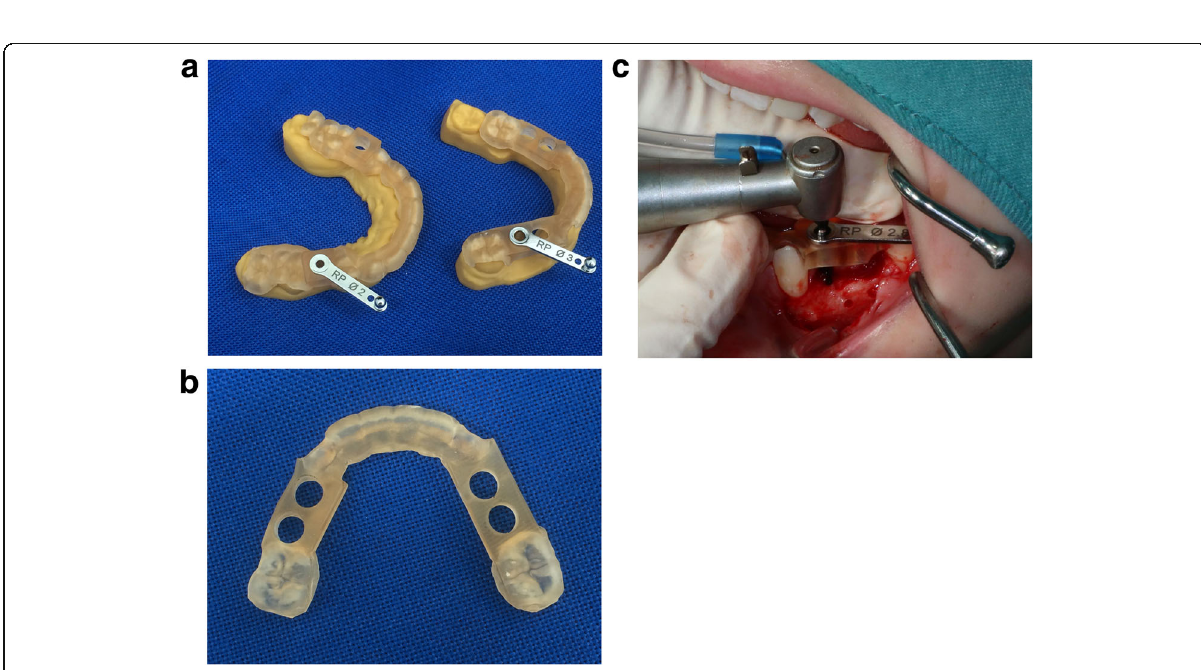
Fig. 5 a Drilling templates of patient 1. Printed model of the maxilla ( left ) and mandible (right) with drilling template and metal drilling inserts (Nobel biocare). b Drilling template for the mandible of patient 1. c Implant placement of patient 1. Dental implant placement in the mandible using the virtual developed tooth-supported templates and metal drilling